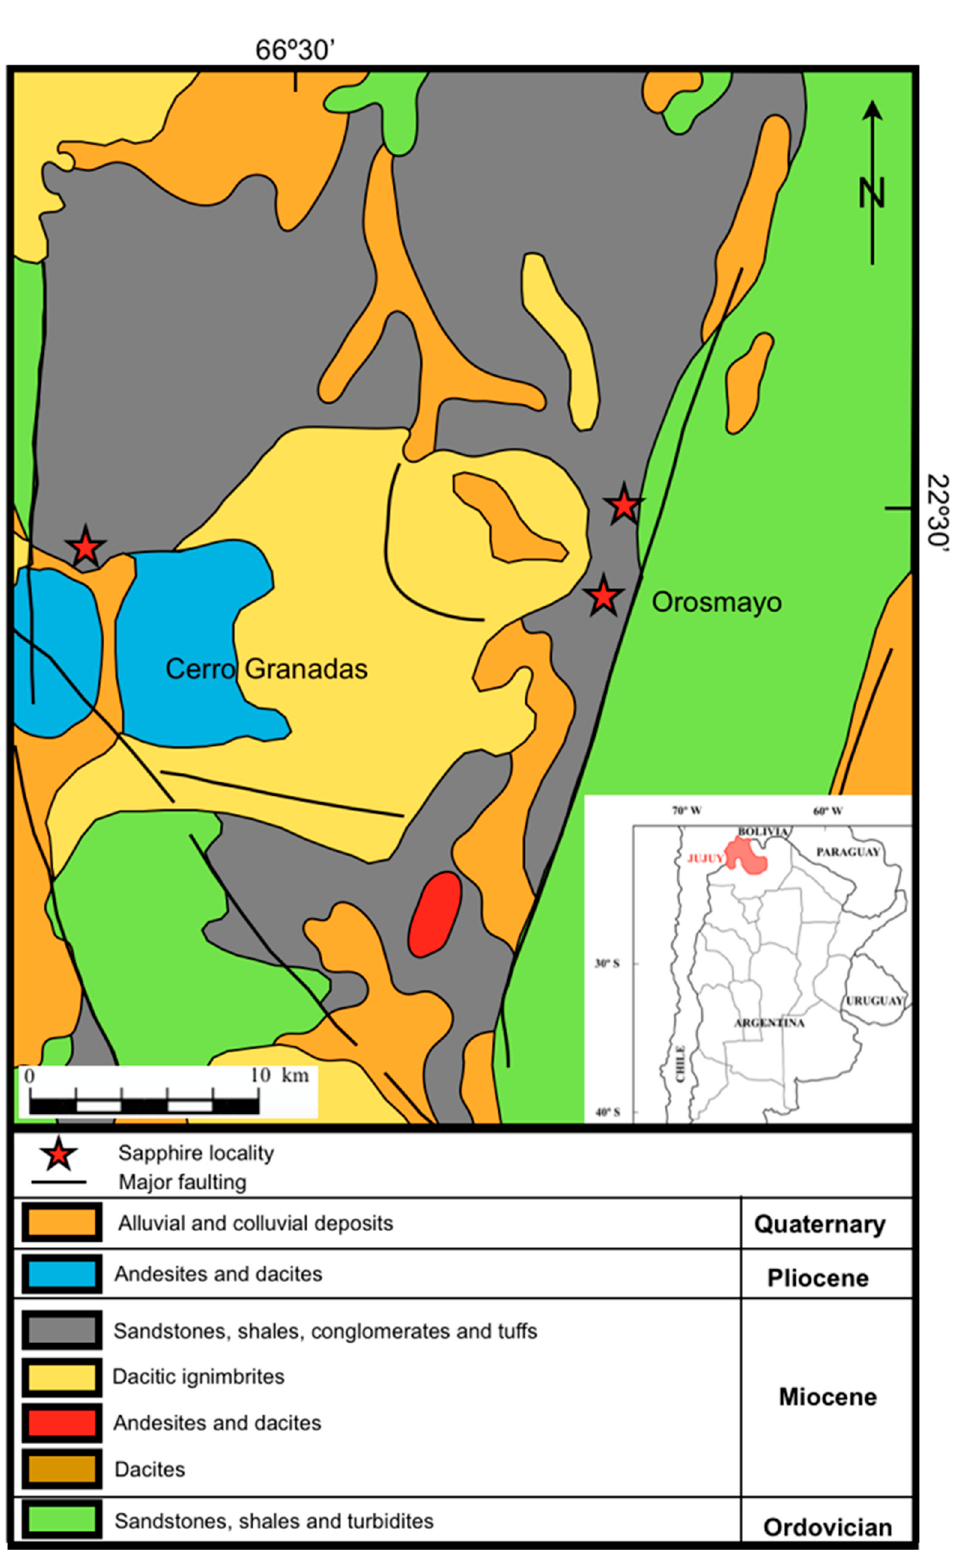
Figure 1. Map showing the location of Orosmayo in northwest Argentina (adapted from Harris et al. 2017) [15].